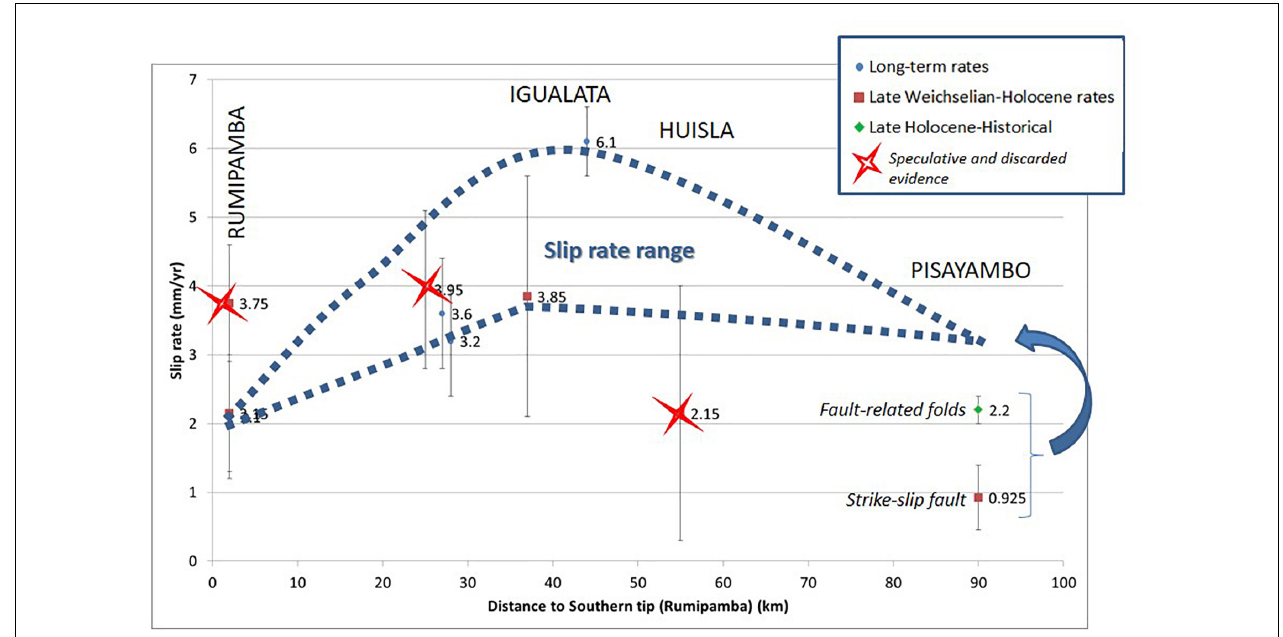
FIGURE 13 | Synthesis of slip rate estimation along the section of the 90 km Pallatanga fault system of concern. This graph is based on observed offsets of landscape features and stratigraphic layers, and related uncertainties and reliability, reported in Table 1